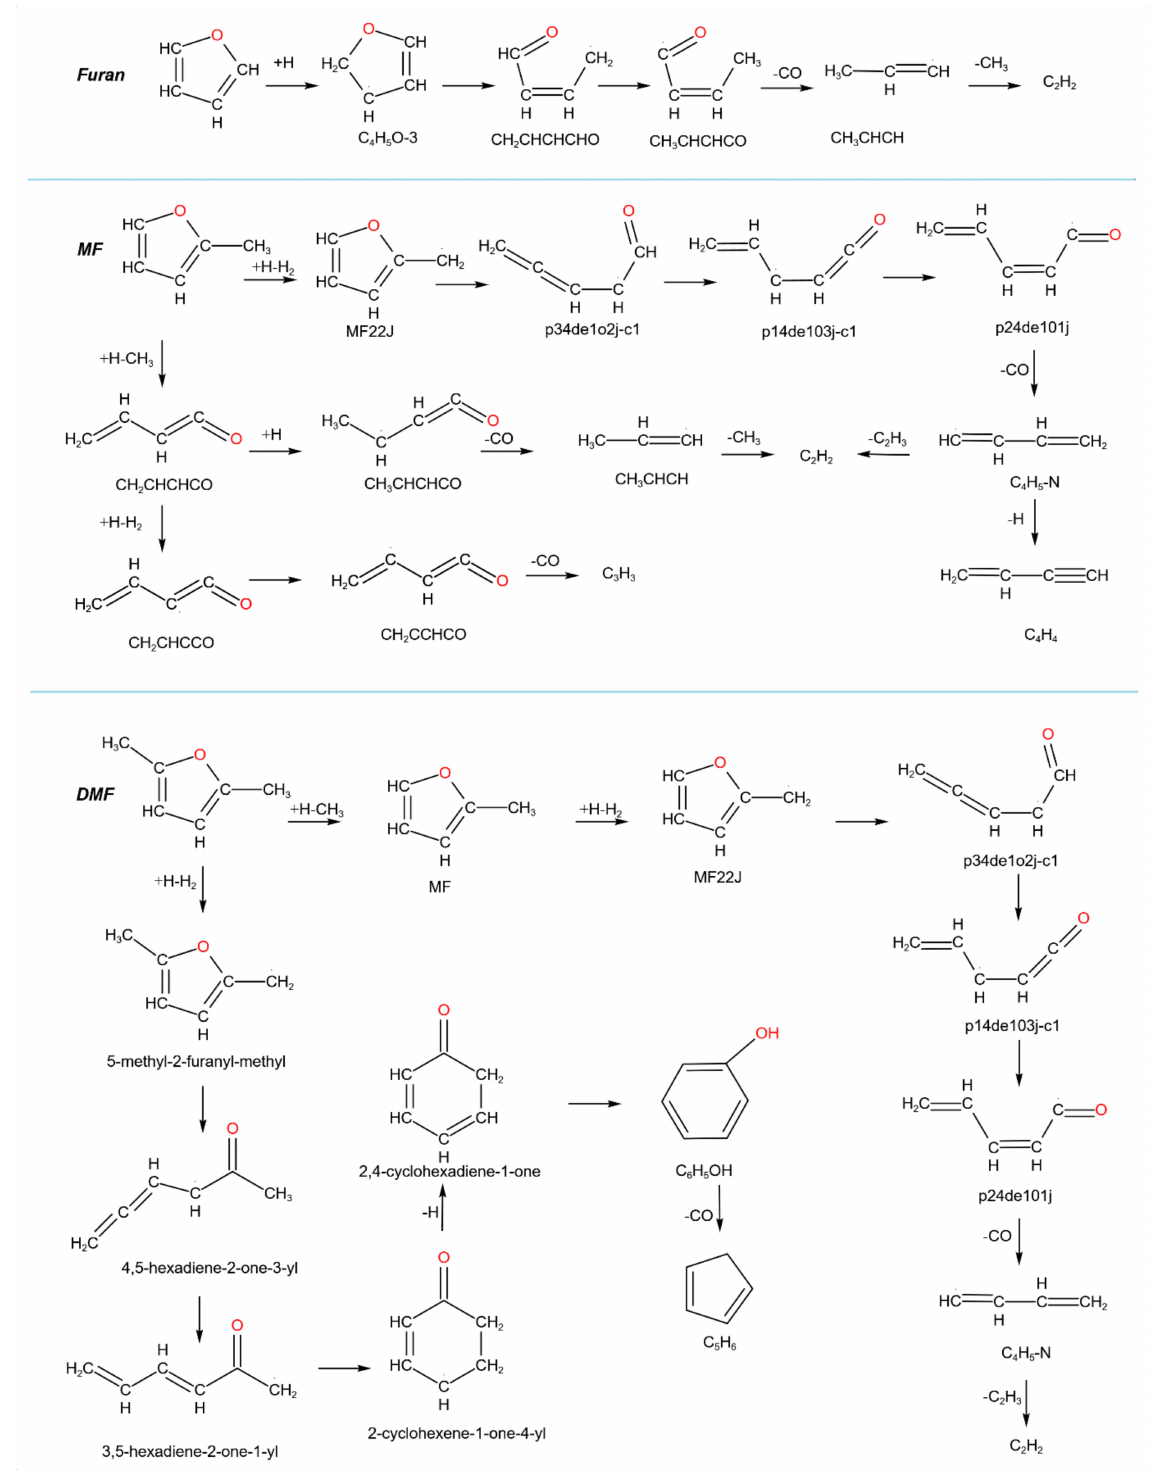
Figure 7. Major fuel decomposition pathways and the formed decomposed products for furan, MF, and DMF. Supporting the reaction pathway analyses, the concentration of several important intermediate products during the decomposition of furan, MF, and DMF are shown in Figure 8. As can be seen, furan flame has the least amount of (a) C 3 H 3 , (b) C 6 H 5 , (c) C 4 H 4 , and (d) C 6 H 5 OH concentrations. As will be detailed later, these species are important precursors of benzene formation and PAH growth. This can be the reason for the lower soot production in furan flame compared to MF and DMF flames. When comparing MF